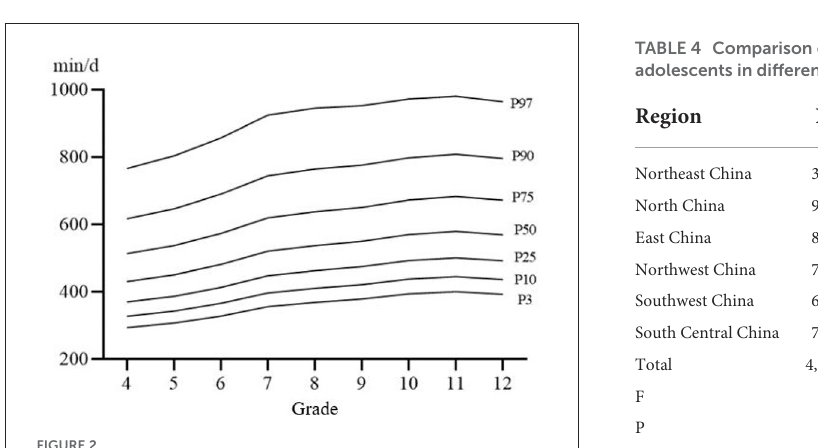
FIGURE2 The percentile distribution curve of sedentary time in weekdays.